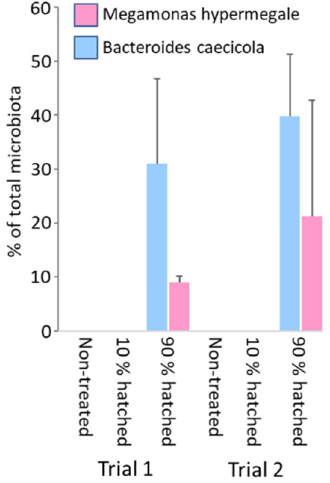
Figure 5. Definition of the timepoint when chickens can be colonised by experimentally administered bacterial strains. Hatching eggs were sprayed with a mixture of Bacteroides caecicola and Megamonas hypermegale, either when 10% of chickens were already hatched or when 90% of chickens were hatched. Five control chickens were not treated at all. All tested chickens became efficiently colonised only when the majority of them were already hatched and became active.